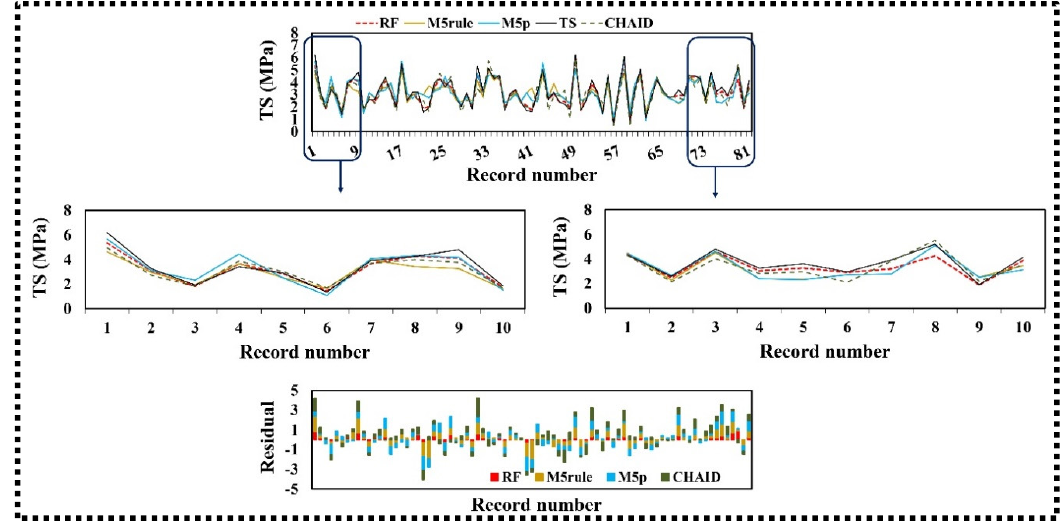
Figure 7. Time series and residual plots of the testing phase of the classification-based regression methods for TS estimation.